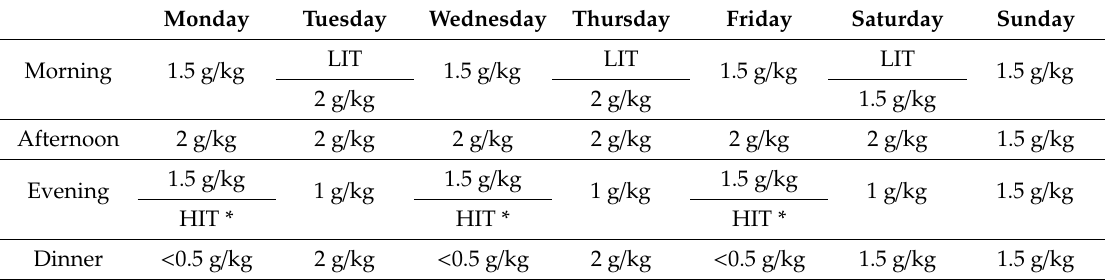
Table 1. An example of a CHO periodization during a week for an endurance